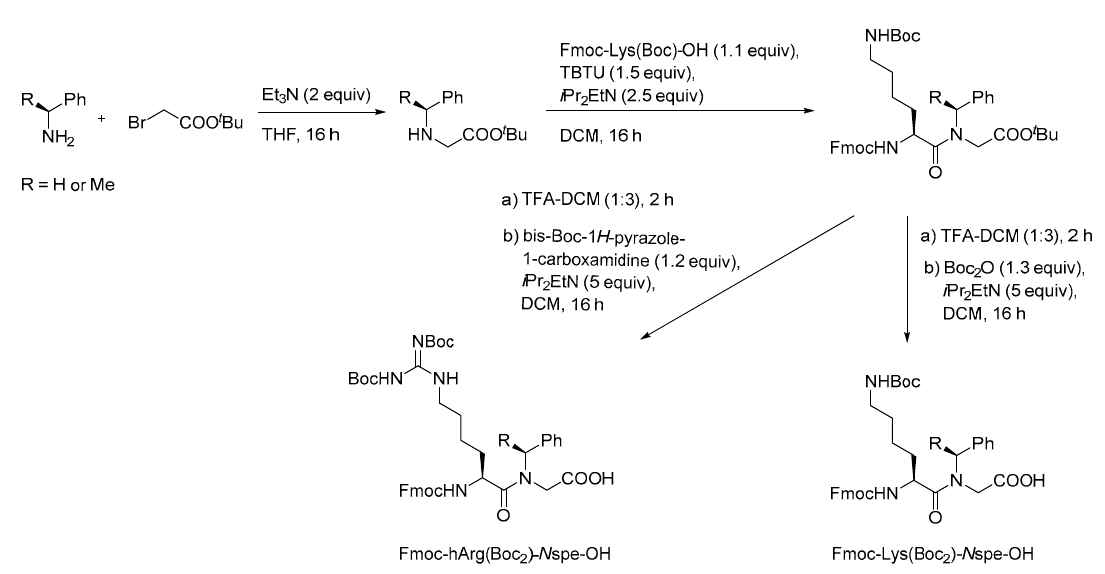
Figure 10. Dimeric building blocks obtained by solution-phase methods [214].